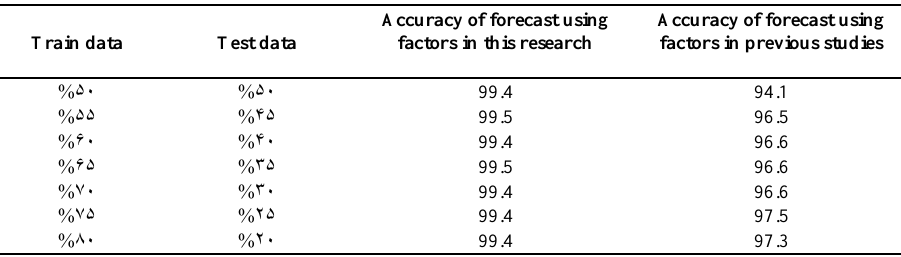
Table 5. The forecast accuracy using the MLP method.